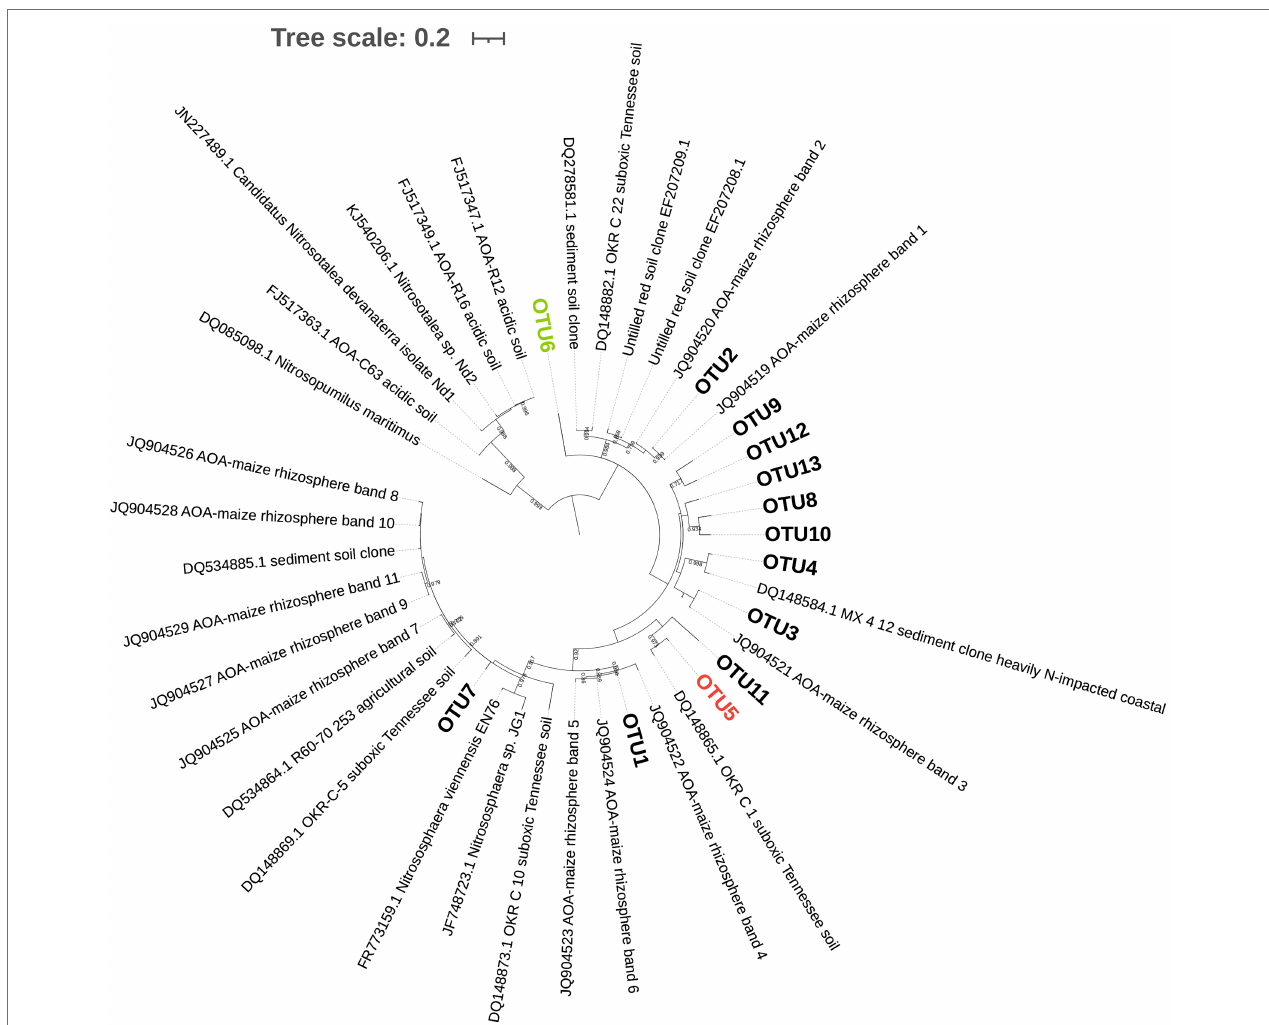
FIGURE 3 | Phylogenetic tree of AOA with the 13 operative taxonomic units (OTUs) obtained after clustering amplicon sequence variants (ASVs) at 90% identity threshold. Green and red labels indicate OTUs highly correlated with PC1 in Figure 2 . The evolutionary history was inferred by using the Maximum Likelihood method based on the Tamura 3-parameter model (lowest Bayesian Information Criterion index, BIC) in MEGAX. The tree with the highest log likelihood ( − 3195.09) is shown. Bootstrap values (>65%) are shown at branch nodes. A discrete Gamma distribution was used [five categories (+G, parameter = 0.9061)]. The rate variation model allowed for some sites to be evolutionarily invariable [(+I), 46.46% sites]. The tree is drawn to scale, with branch lengths measured in the number of substitutions per site. The analysis involved 42 nucleotide sequences, including 13 OTUs and 29 database sequences. All positions with less than 95% site coverage were eliminated (partial deletion option). There were a total of 261 positions in the final dataset. Interactive Tree of Life (iTOL) tool was used for tree visualization.